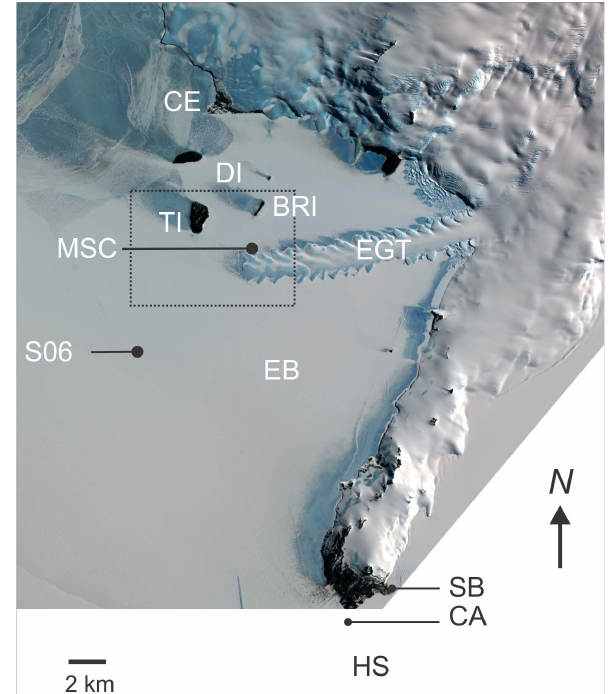
Fig. 2. ASTER (Advanced Spaceborne Thermal Emission and Re- flection Radiometer) satellite image of south east McMurdo Sound including the Erebus glacier tongue (EGT), the Dellbridge Islands (DI) including Tent Island (TI) and Big Razorback Island (BRI), Erebus Bay (EB), Cape Evans (CE). Cape Armitage (CA), Haskell Strait (HS), Scott Base (SB) and the microstructure field camp (MSC). The measurements described in Stevens et al. (2006) come from S06. The dashed box shows the locale for Fig.